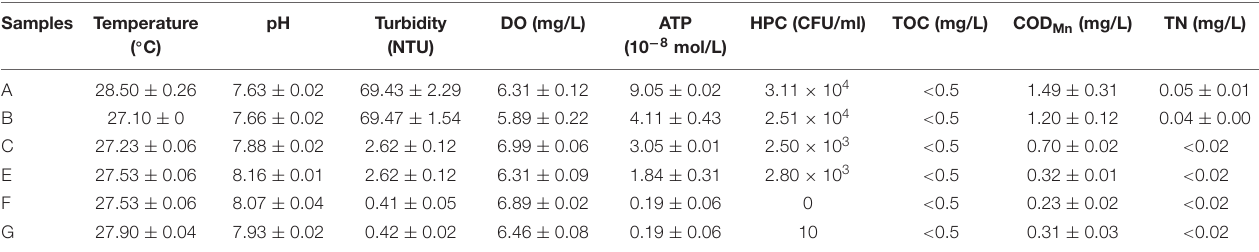
FIGURE 1 | Process diagram of the DWTP and sampling sites. Sampling points: A: raw water; B: flocculation tank effluent; C: sedimentation tank effluent; D: quartz sand; E: sand filter effluent; F: chlorine-disinfected water; and G: tap water. TABLE 1 | Physicochemical and microbiological parameters measured at different treatment units for drinking